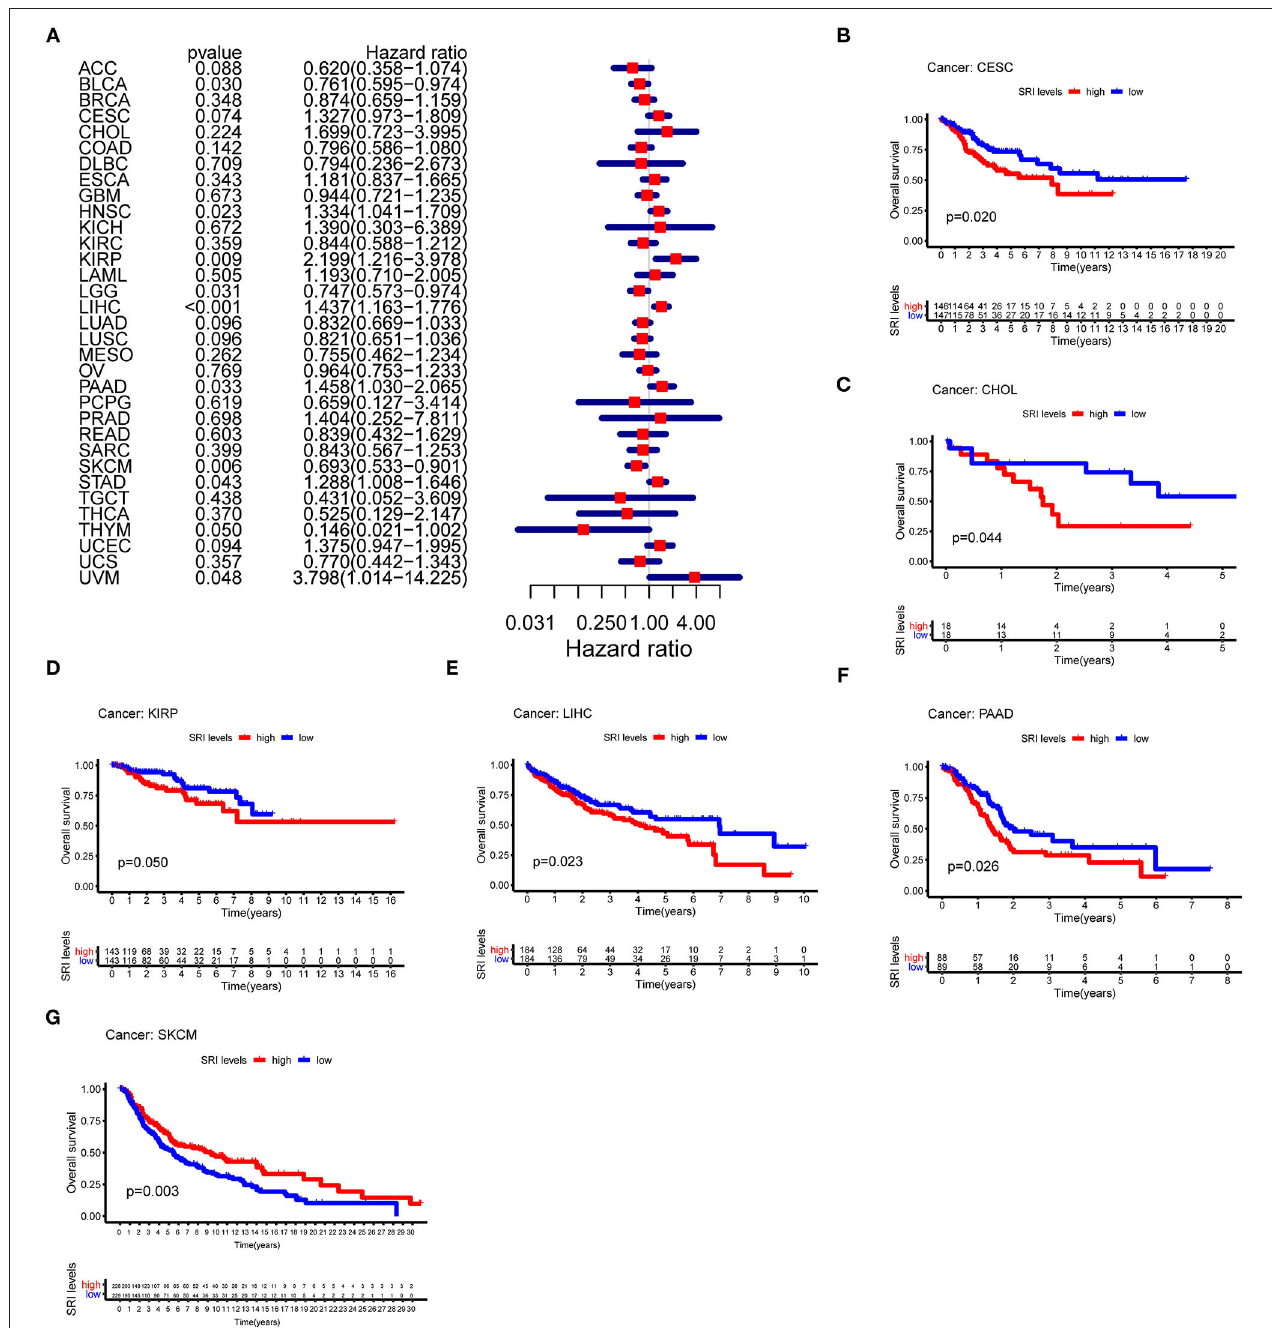
FIGURE 2 | The Cox proportional hazards model and Kaplan–Meier analysis of overall survival (OS) time by the SRI expression. (A) A forest plot of the associations of SRI expression and OS in 33 types of tumor. (B–G) Kaplan–Meier analysis of the correlations between the SRI expression and OS. A red line represents high SRI expression, and the blue lines represent low SRI expression.